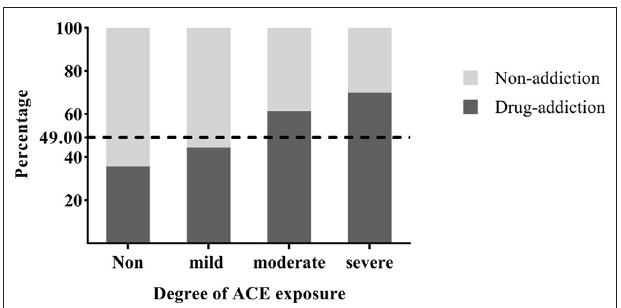
FIGURE 2 | Proportions of drug users with different ACE exposure levels. The dotted line represented the proportion of participants with drug addiction in all.